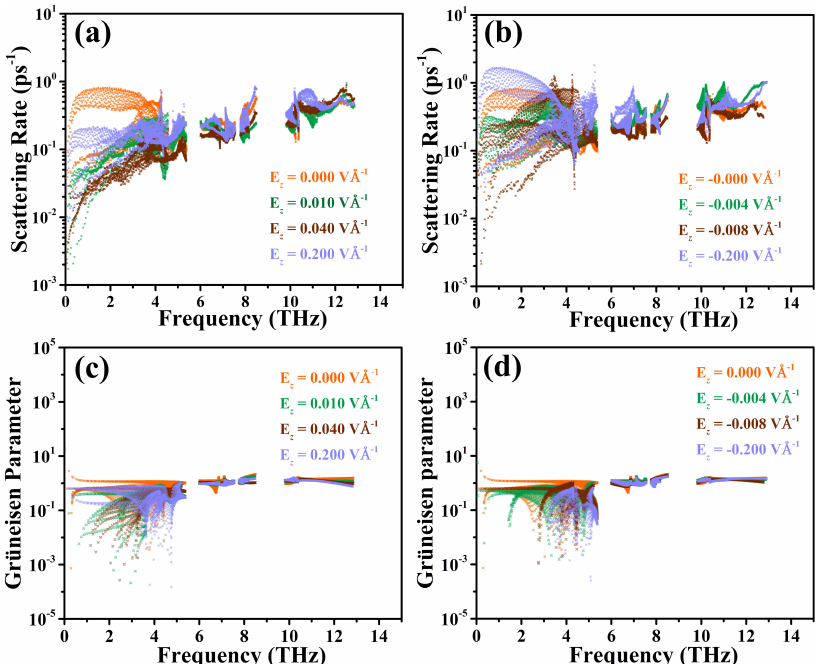
Fig. 3 The comparison of scattering rate and Grüneisen parameter under different external electric fi elds. a , c For positive electric fi elds. b , d For negative electric fi